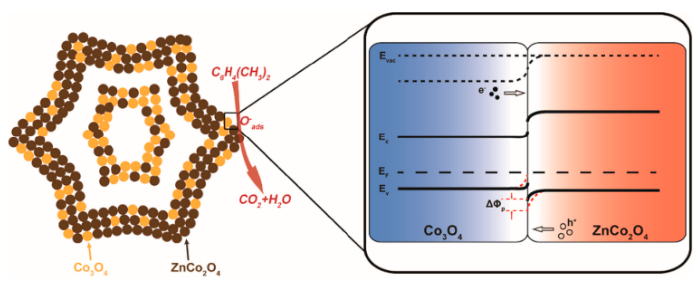
Figure 18. Schematic illustration of the proposed gas sensing mechanism of Co 3 O 4 /ZnCo 2 O 4 composite hollow nanostructure [82] .